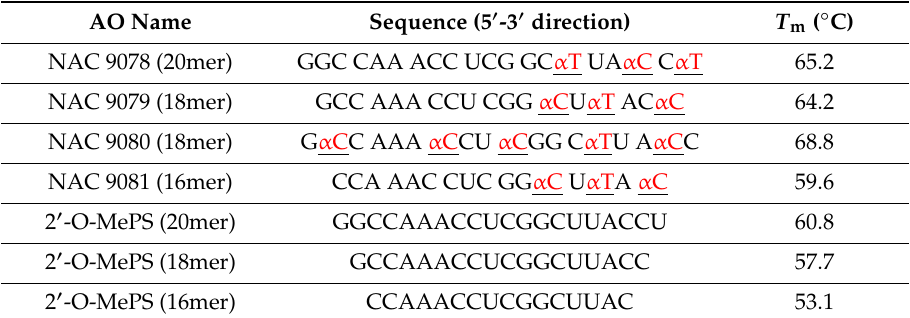
e ffi cient exon-23 skipping (Figure 2). The exon skipping e ffi ciency was similar or even better when (cid:48) directly compared with the corresponding 2 -OMePS AOs (Figure 2A). Highest exon skipping was observed at 50 nM and 100 nM with 66% and 74% of the 688 bp skipped transcript product (Figure 2B). Table 1. Sequences used in this study.